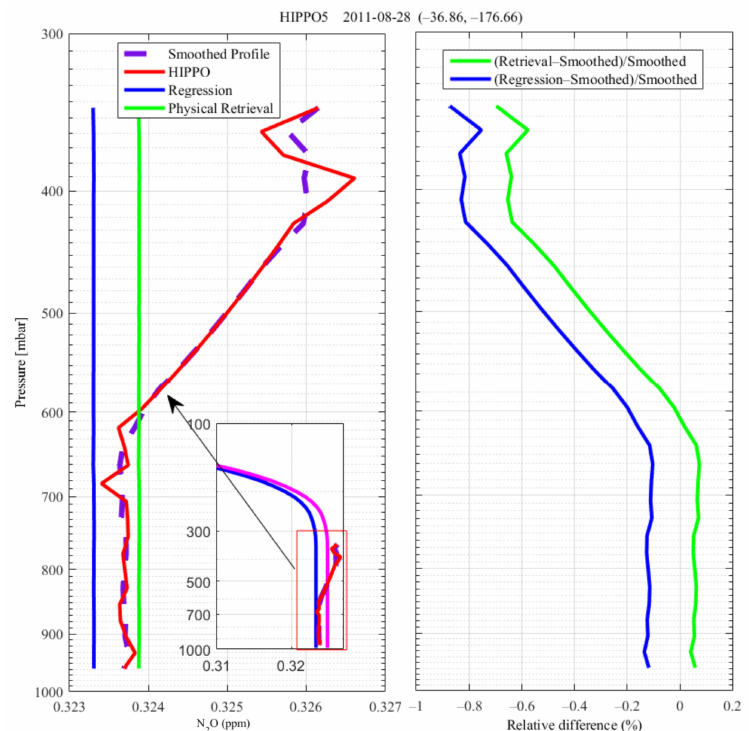
Figure 14. An example of the retrieval results for the mid-latitude region of the Southern Hemisphere (left) and the RD between the retrieval results and the HIPPO data (right).